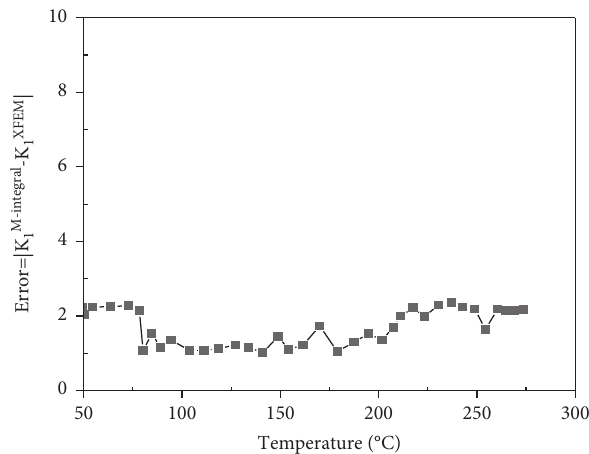
Figure 19: Error margin between the results of M-integral and XFEM K